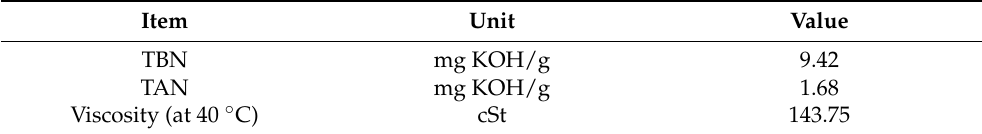
Table 1. Waste engine oil analysis sheet.